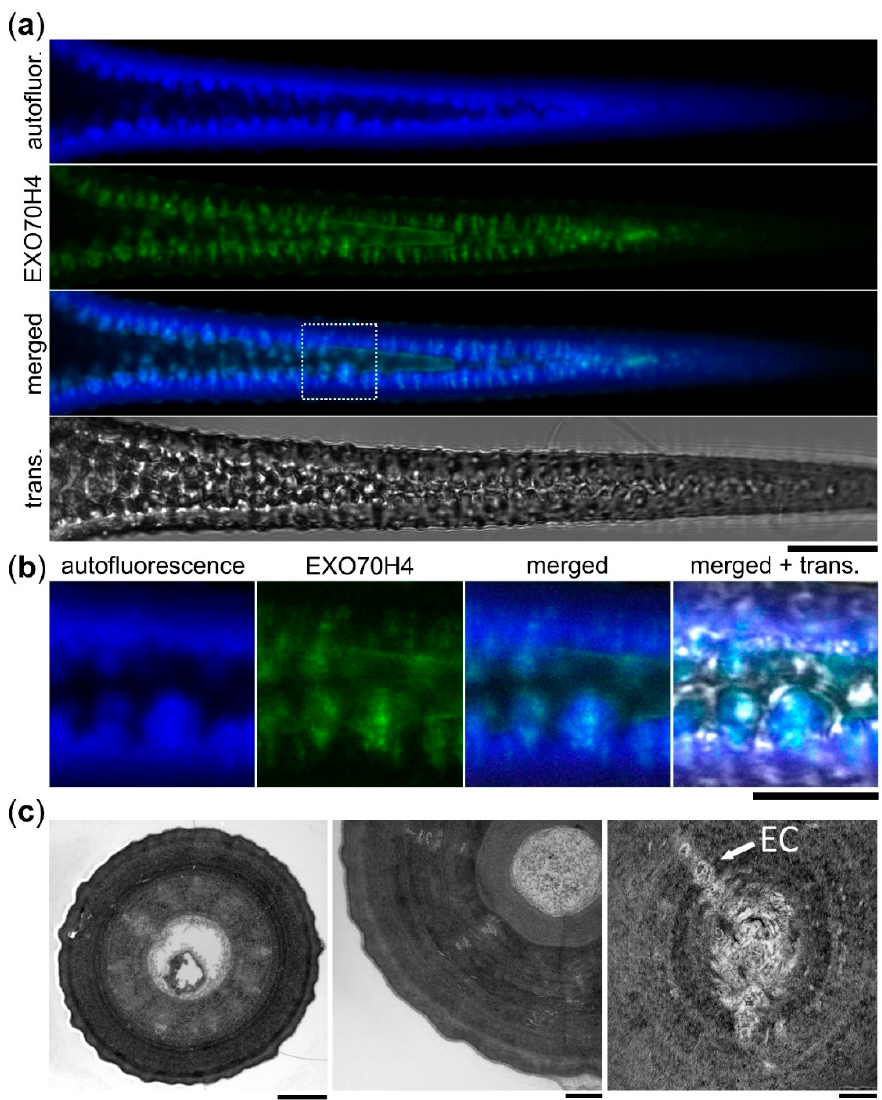
Figure 4. Plasma membrane proteins reside within the trichome apical cell wall. ( a ) GFP-EXO70H4 (EXO70H4) signal, cell wall autofluorescence (autofluor.), and transmission channel (trans.) at the branch of a mature WT trichome. The dotted square represents area enlarged in ( b ). Scale bar = 20 µ m. ( b ) Detail of ( a ). Scale bar = 10 µ m. ( c ) Left—TEM image of a cross-section of a trichome branch. Entrapped cell interior (EC) is visible as concentric rays. Scale bar = 3 µ m. Middle—detail of entrapped cell interior obviously separated from the cytoplasm. Scale bar = 1 µ m. Right—a detail of one concentric ray. Scale bar = 200 nm.